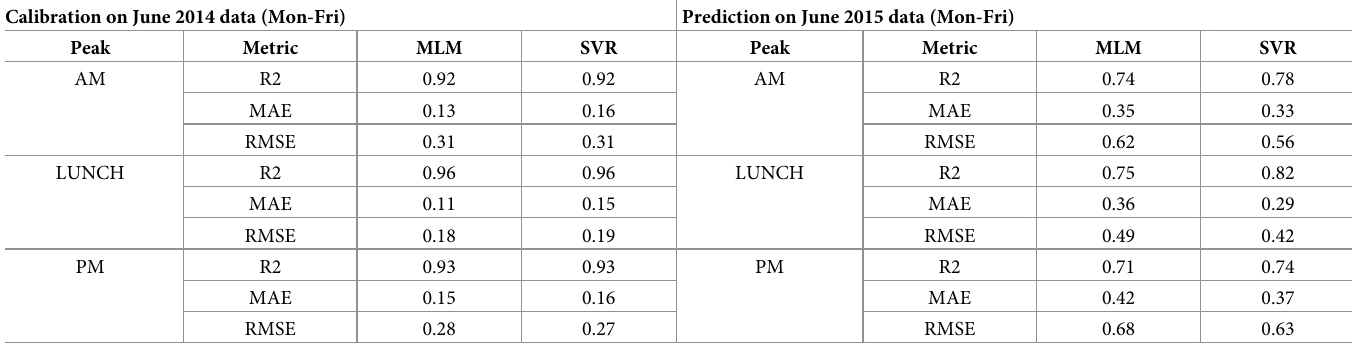
Table 3. Goodness of fit results of MLM and the chosen SVR model for 10 types of pedestrian flows combined with weather and day-of-week variables, with sensor- level dummies. Left: calibration results on June 2014 data. Right: prediction results on June 2015 data. Calibration on June 2014 data